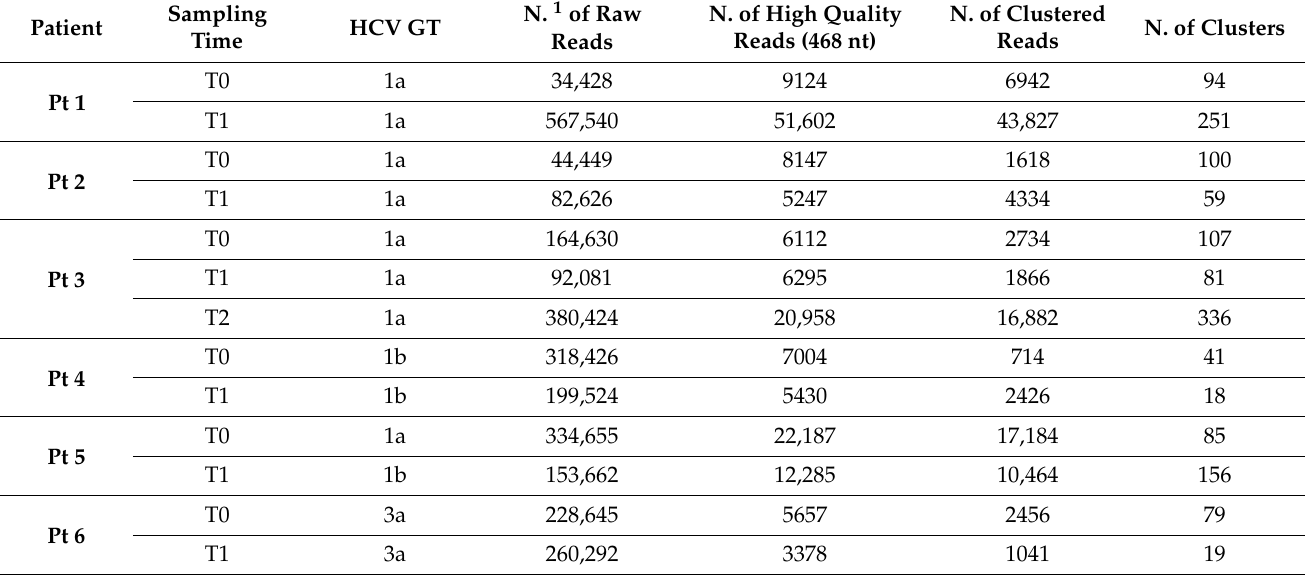
Table 1. NGS analysis of the number of sequence reads and clusters per patient sample.